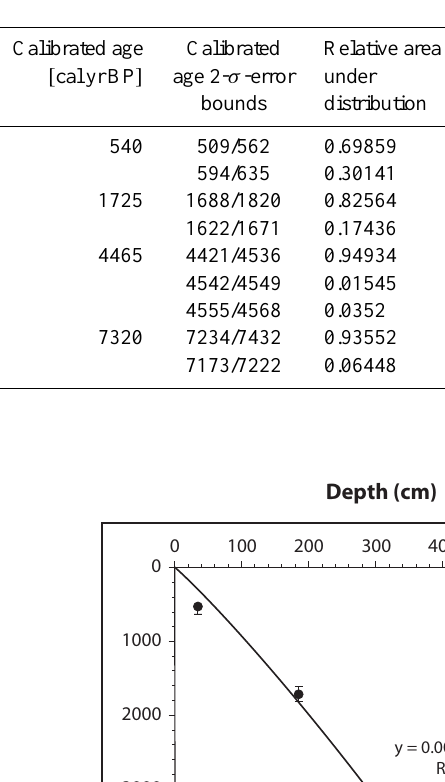
Table 1. Radiocarbon chronology of core M4, Lake Mbalang, Central Cameroon.